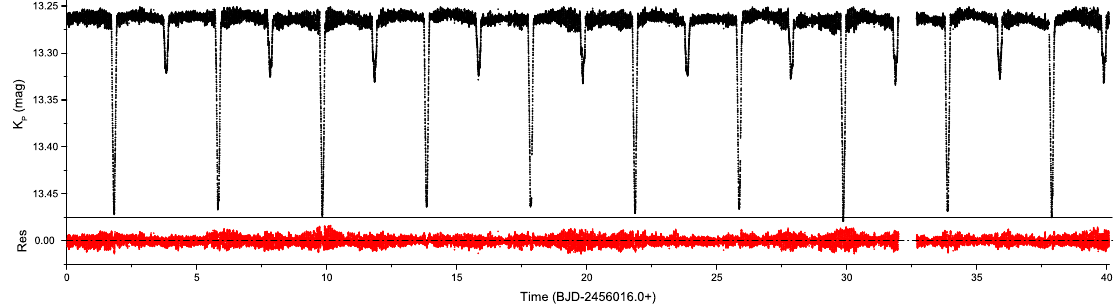
Figure 3. Short-cadence light curves (LCs) (black points) for KIC 8504570 and their residuals (red points) after the subtraction of the LC models. The plotted data concern only the first 40 days of observations, and the rest are not shown due to scaling